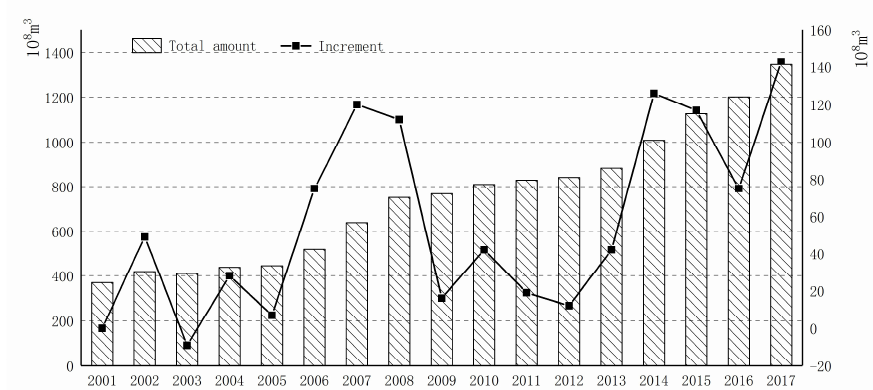
Figure 7. The annual amount and increase in seawater used directly in cooling projects in China. Data Source: State Oceanic Administration of China “The National Seawater Utilization Report in 2017”.